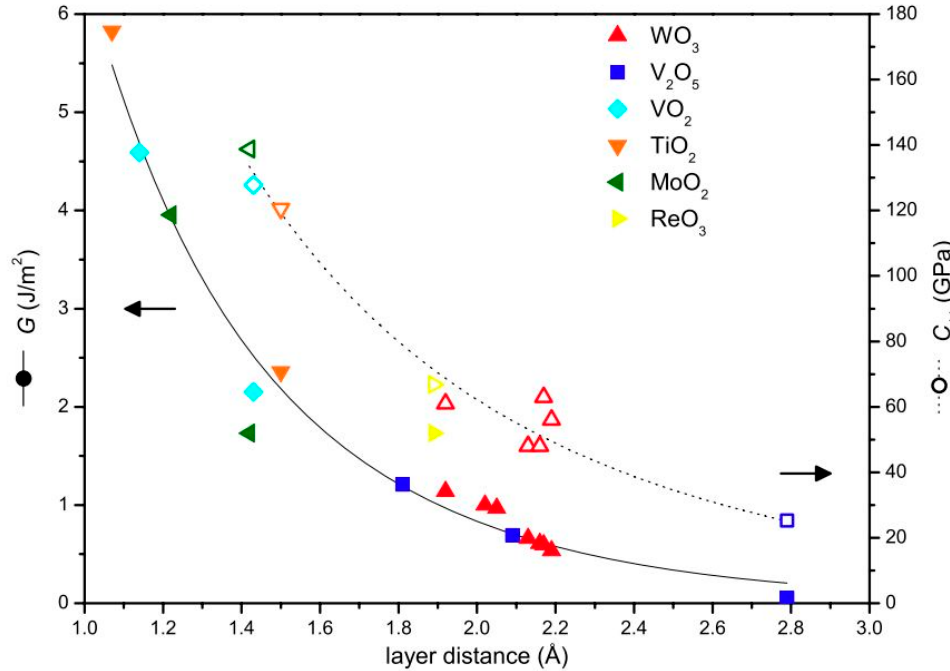
Figure 12. Contemplation of oxides forming Magn é li phase based on their de-cohesion energy (G) and elastic constant (C 44 ) as a function of the distance between the cleaved layers [109]. Vanadium oxides are stated to form similar Magn é li lubricious phases as that of ti- tanium, analogous to the general formulations V n O 2n − 1 and V n O 2n+1 , with V 2 O 5 [117]. The de-cohesion energy of the layers of V 2 O 5 is the lowest resulting in an easy crystallo- graphic shearing (Figure 12) [109]. The formation of wear-reducing phases of V 2 O 5 and TiO 2 on (V, Ti)N coating at 500–700 ◦ C resulted in CoF to drift around 0.5 [118]. However, at 700 ◦ C, a jump in CoF value to 0.6 was noted due to the coating damage and partial melting. Similar phenomena of coating melting close to 680 ◦ C were stated in [119]. Par- ticularly, Magn é li phases of vanadium show a steady decrease in CoF at temperatures between 400–700 ◦ C due to liquid lubrication resulting in an easy-to-shear microstructure by V 2 O 5 , VO 2, and V 6 O 13 [120–122], accounting for the melting and smearing of such phases. However, a complete melting and vaporization of V 2 O 5 around 700 ◦ C results in a lubrication failure [118–123]. Figure 13 demonstrates the effect of sliding temperature on CoF and relative wear rate values of composites and coatings forming oxides (and Magn é li phases), as reported in recent literature [4,13,118,120,123–127]. The efficient lubrication range is